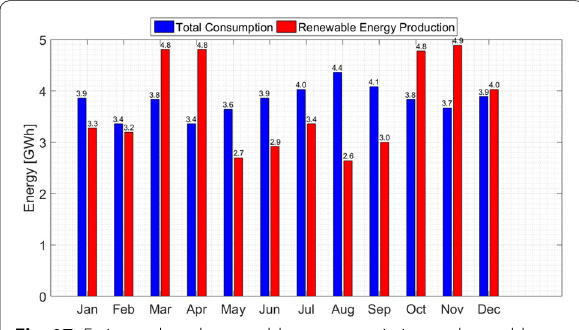
Fig. 17 Estimated total renewable energy emission and monthly consumption for 2018 in Faial